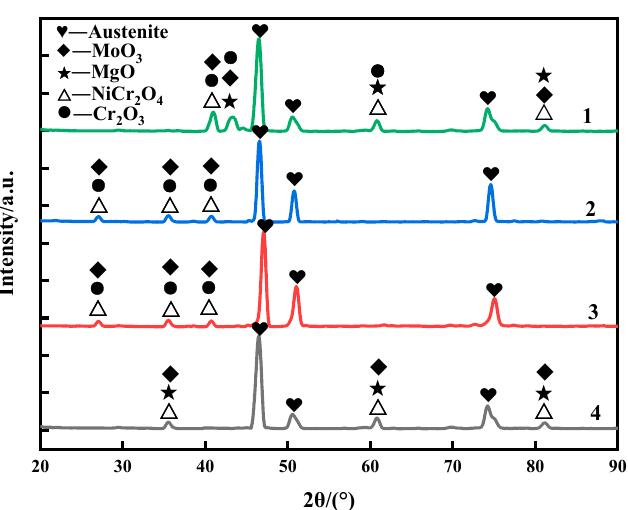
Figure 5. Surface phase composition of the nitrogen-containing low-nickel weld claddings and Inconel 625 weld cladding after corrosion for 10 h (1. 2. 3 are nitrogen-containing low-nickel weld claddings, and 4 is Inconel 625 weld cladding).